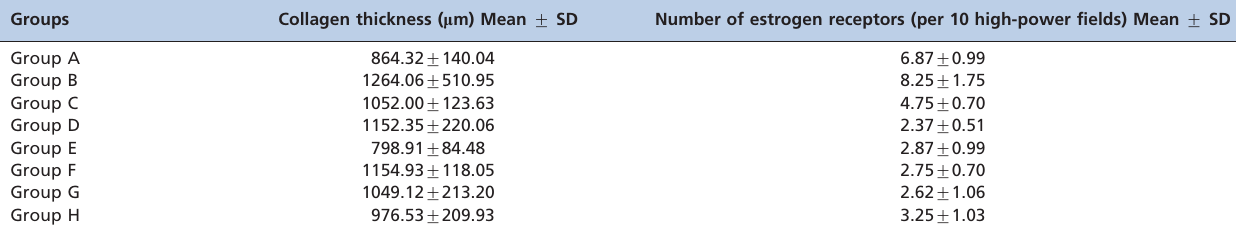
Table 1 - Mean values of the collagen layer thickness and the number of estrogen receptor-positive cells in the skin of animals in the different